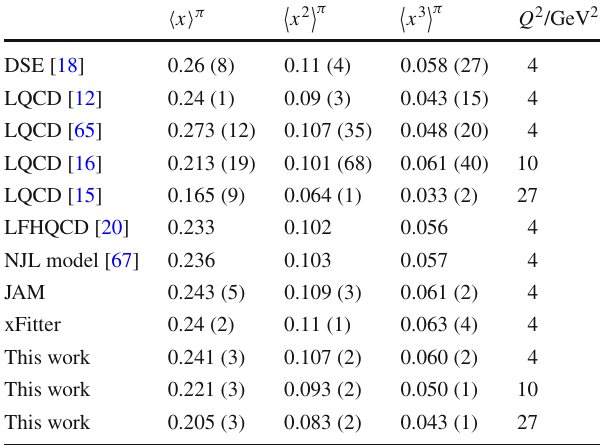
(cid:4) (cid:5) (cid:4) (cid:5) x 2 x 3 , of quark